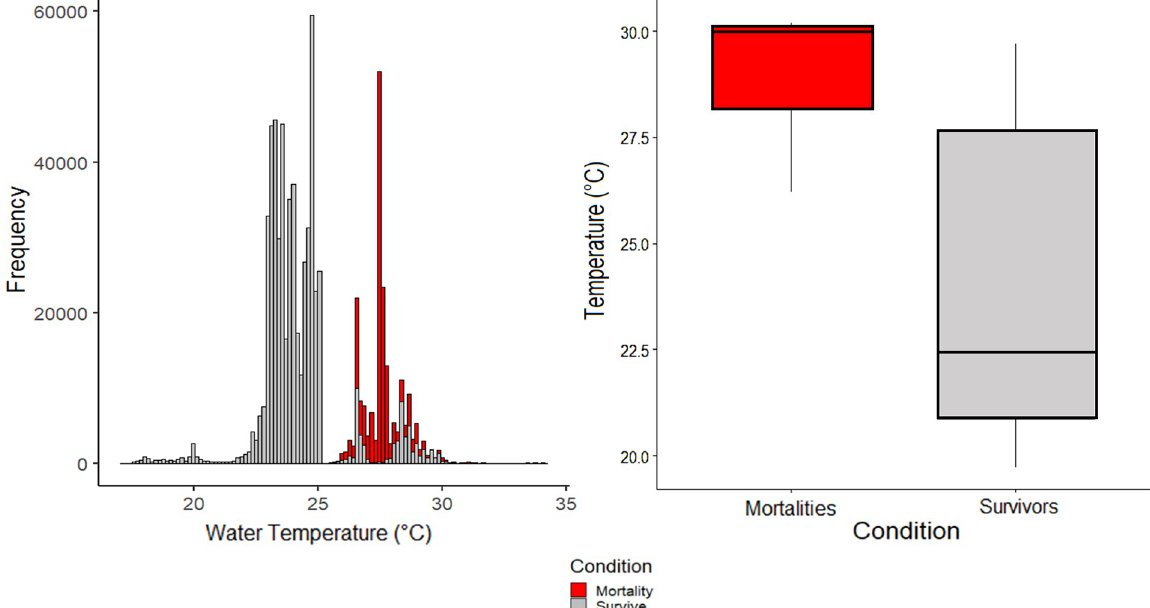
Fig 6. Temperature distributions for blacktip shark survivors (grey) and mortalities (red) across each groups time at large (Left, Kolmogorov- Smirnov two sample test, p < 0.0001). (B) Boxplots comparing average initial temperature from the first 10 minutes immediately following release between blacktip sharks that survived capture and release and those that did not (Right, Kruskal-Wallis test, p = 0.045).